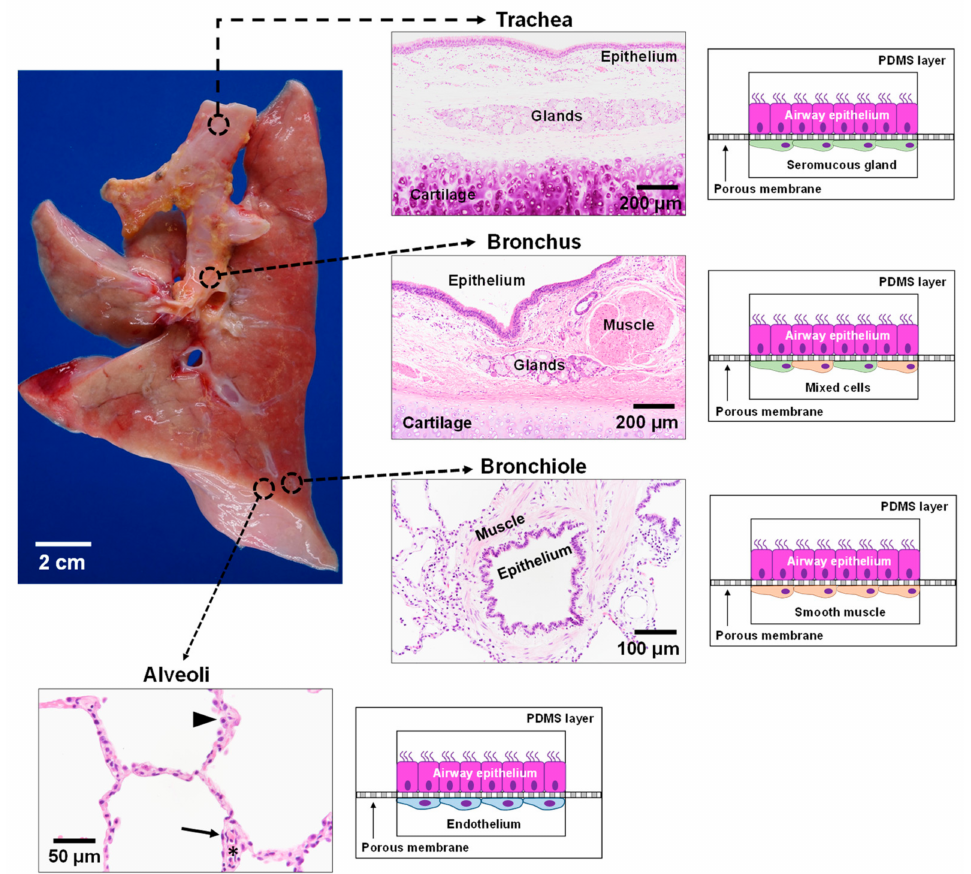
Figure 4. Schematic of lung-on-a-chip models to represent the unique microenvironments throughout the respiratory tract. Four separate microfluidic devices represent four functionally distinct regions of the lung. The alveoli are lined by epithelial type II cells (arrowhead) and type I cells (arrow) that are in close proximity to the endothelial cells lining the capillaries containing red blood cells (*). Each lung-on-a-chip model contains different epithelial cell types specialized for region specific functions with distinct cell populations in the subepithelial compartment to mimic the unique cell–cell interactions seen in spatio-regionally distinct lung